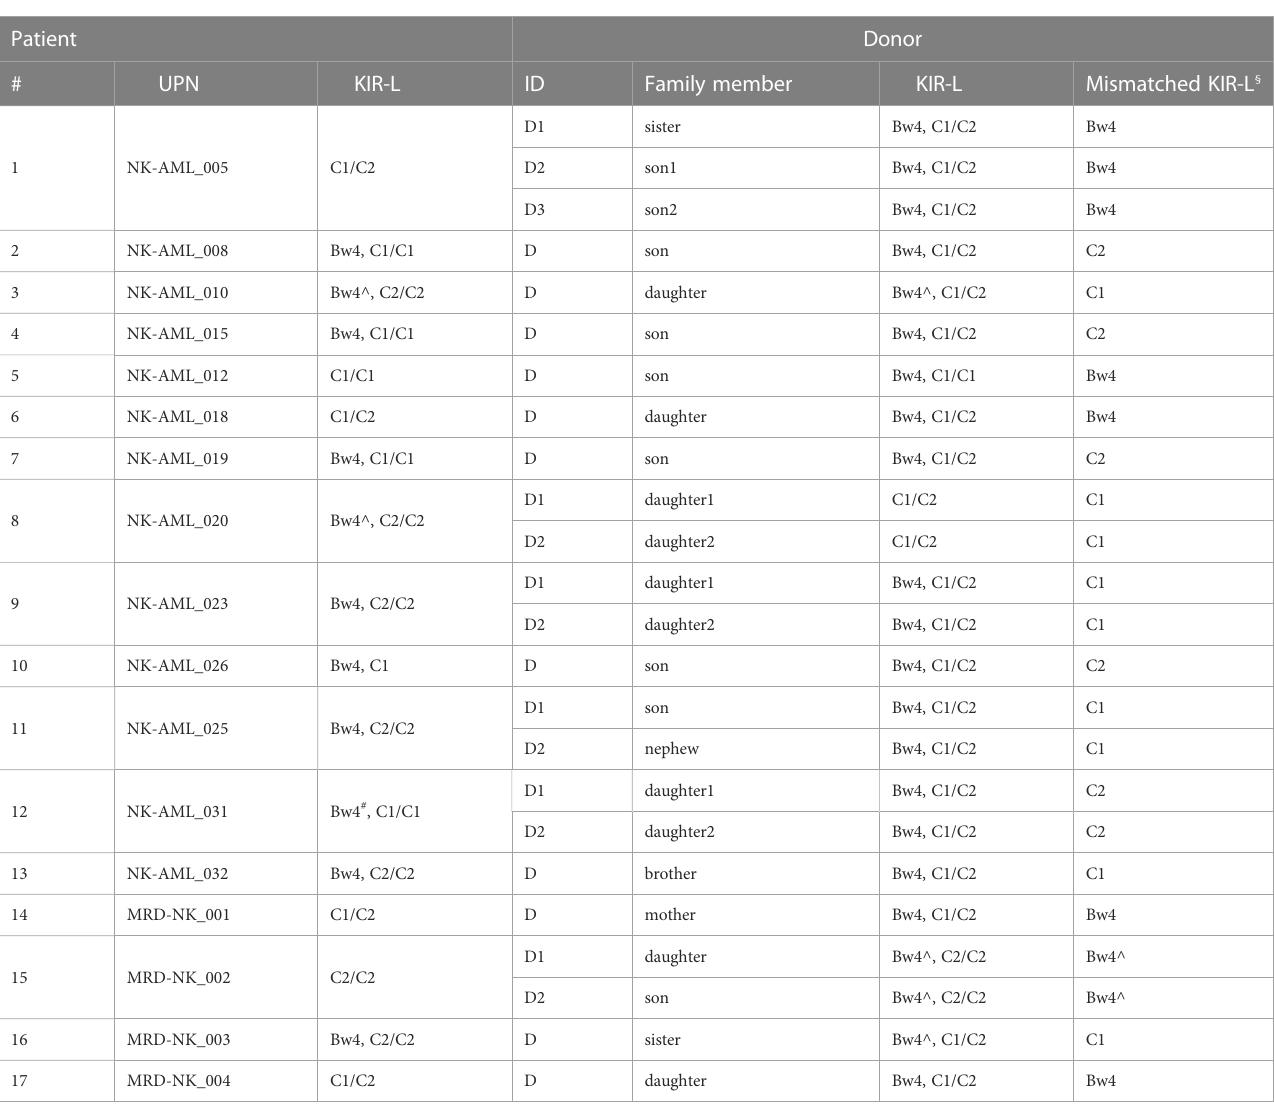
D indicates when a unique donor was available, while D1, D2, or D3 when alternative donors were tested. § KIR-L present in the donor and missing in the patient. Bw4^ indicates when the unique Bw4 epitope is represented by B*13:02, an allele that is not a ligand of KIR3DL1 Bw4 # indicates when the unique Bw4 epitope is represented by A*32:01, an allele that is a ligand of